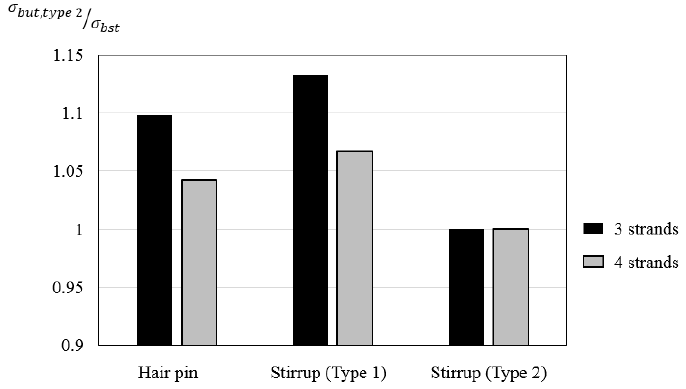
Figure 8. Comparison of bursting stresses.